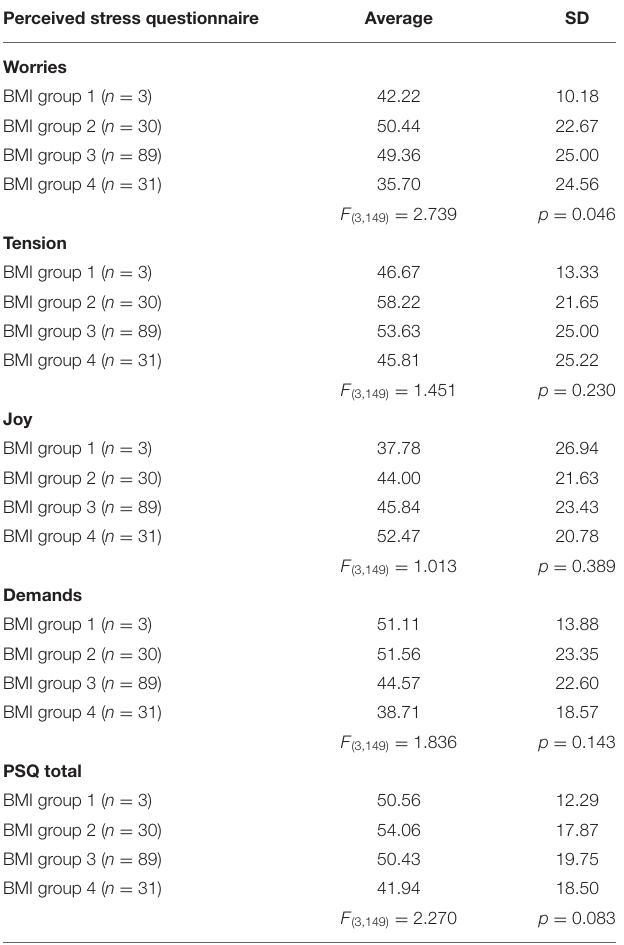
TABLE 3 | Perceived stress